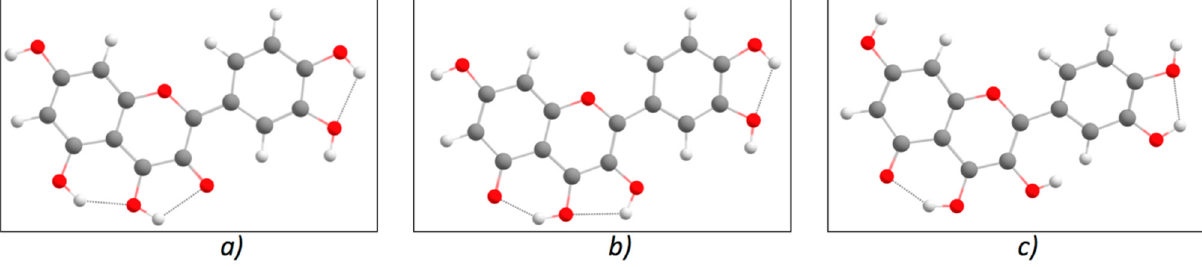
Figure 5. Keto forms of quercetin conformers: ( a ) Q_M keto OH3, ( b ) Q_M keto OH5, and ( c ) Q_A keto OH5.